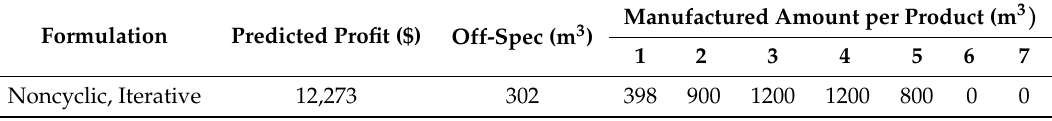
Table 20. Economic results: Additional